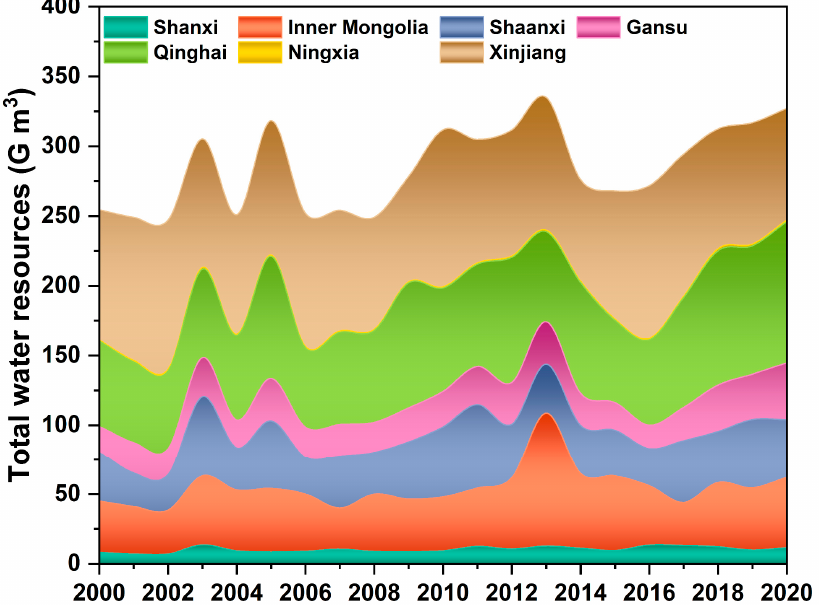
Figure 2. Dynamic changes in total water resources in Northwest China from 2000 to